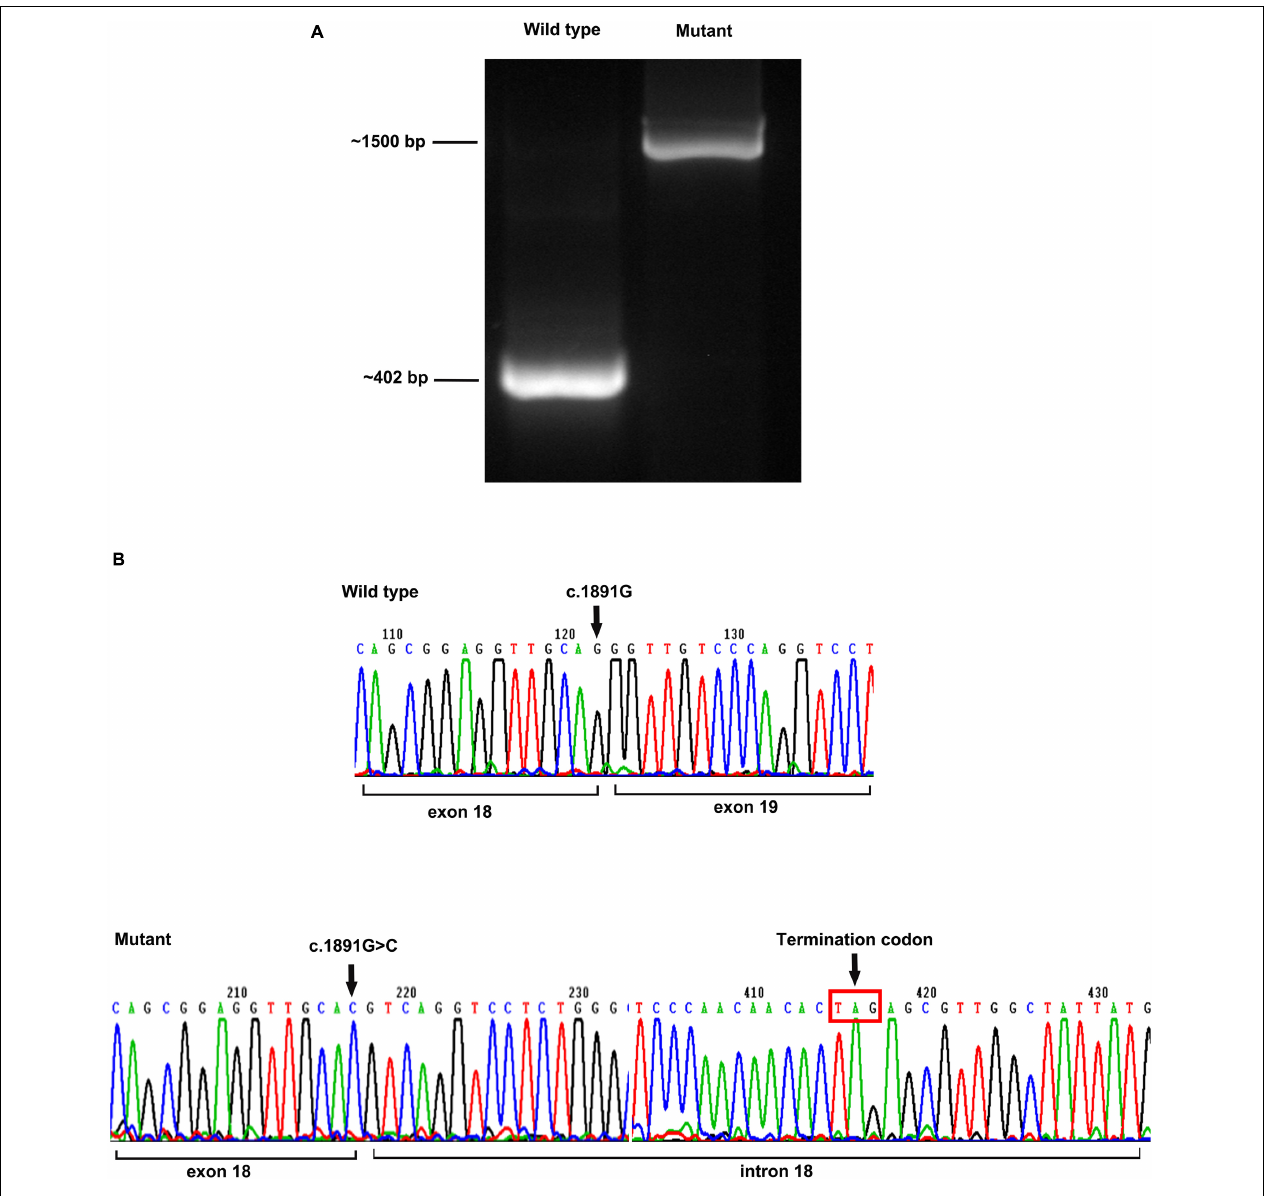
FIGURE 3 | Minigene assay analysis. (A) The size of an electropherogram of PCR product of the wildtype was around 402 bp, and the size of mutant was around 1,500 bp; and (B) sequencing of the cDNA revealed the intron 18 was spliced into the mutant, resulting to the premature appearance of termination codon.